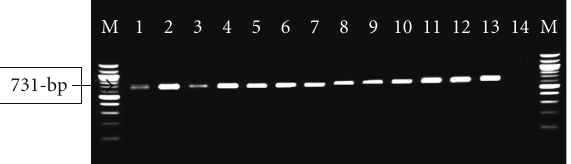
(b) Agarose gel electrophoresis of PCR-amplified IS711 element specific for B. melitensis . The figure shows a single band, a 731-bp DNA fragment. Lanes: M: molecular 100 size ladder (in base pairs); 1–12: B. melitensis positive samples for blood and fetal tissues; 13: positive control; 14: negative control.